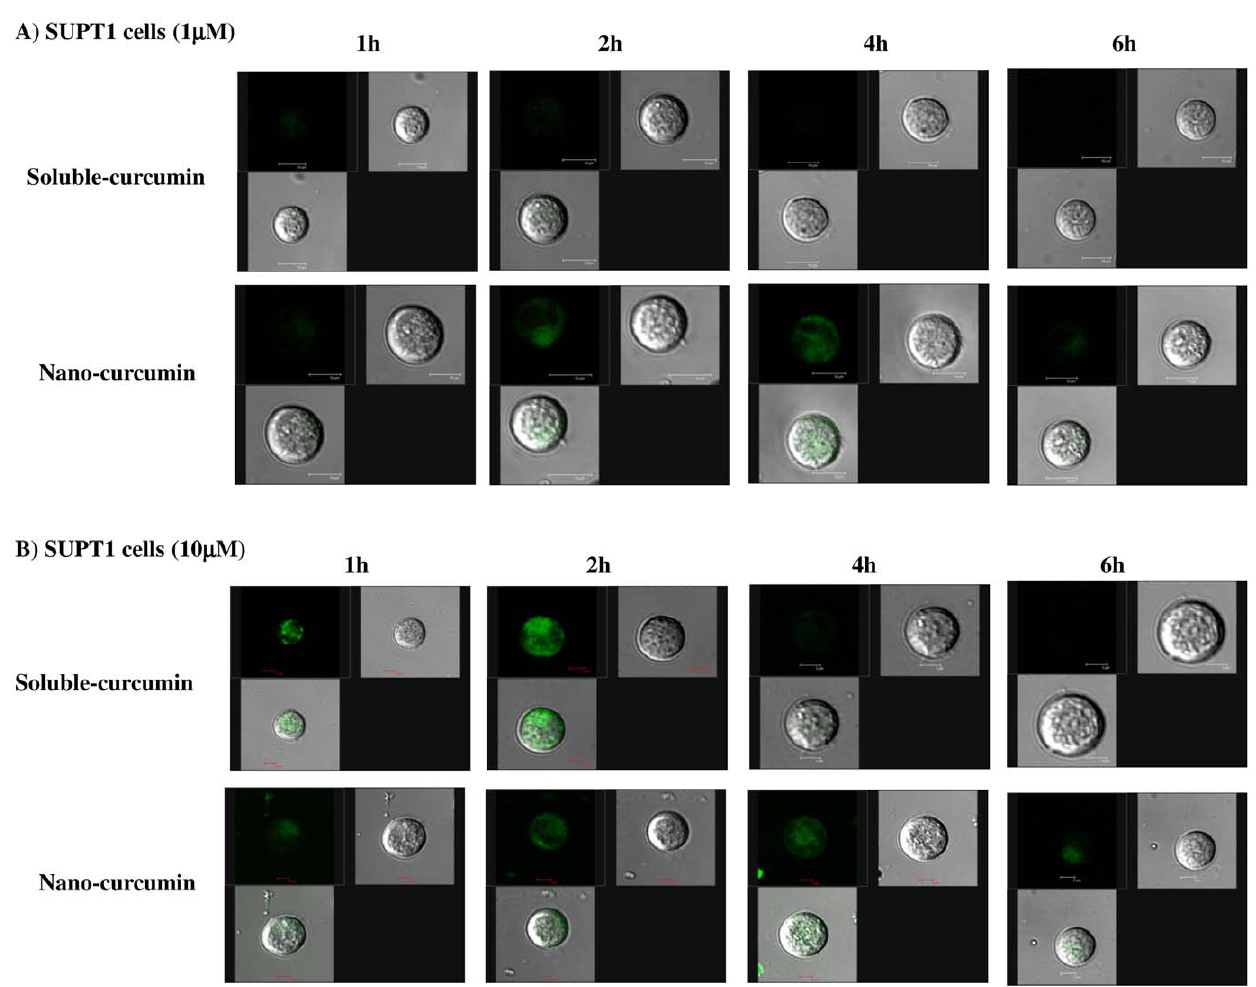
Figure 3. Nanoparticle formulation exhibits increased cellular retention in SUP-T1 cells. Cells were incubated with 1 m M (Panel A) and 10 m M (Panel B) sol-curcumin and nano-curcumin and examined by confocal microscopy at time points of 1, 2, 4 and 6 h. Each panel contains three images: fluorescence, bright field and merged.